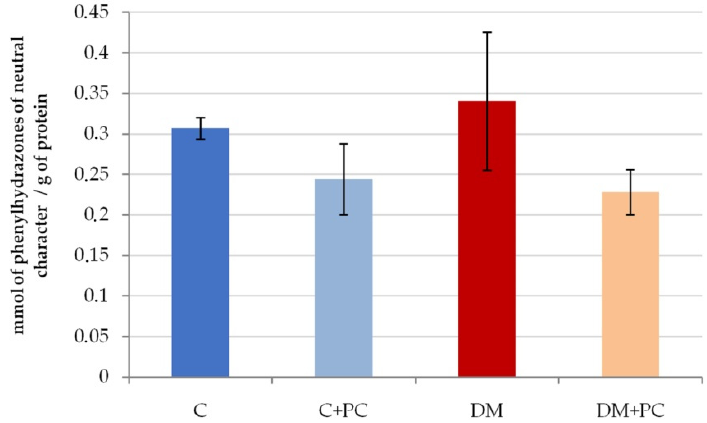
Figure 9. The content of proteins oxidative modification products of neutral character (370 nm) in plasma of control rats, rats with experimental diabetes mellitus, with and without PC concentrate.